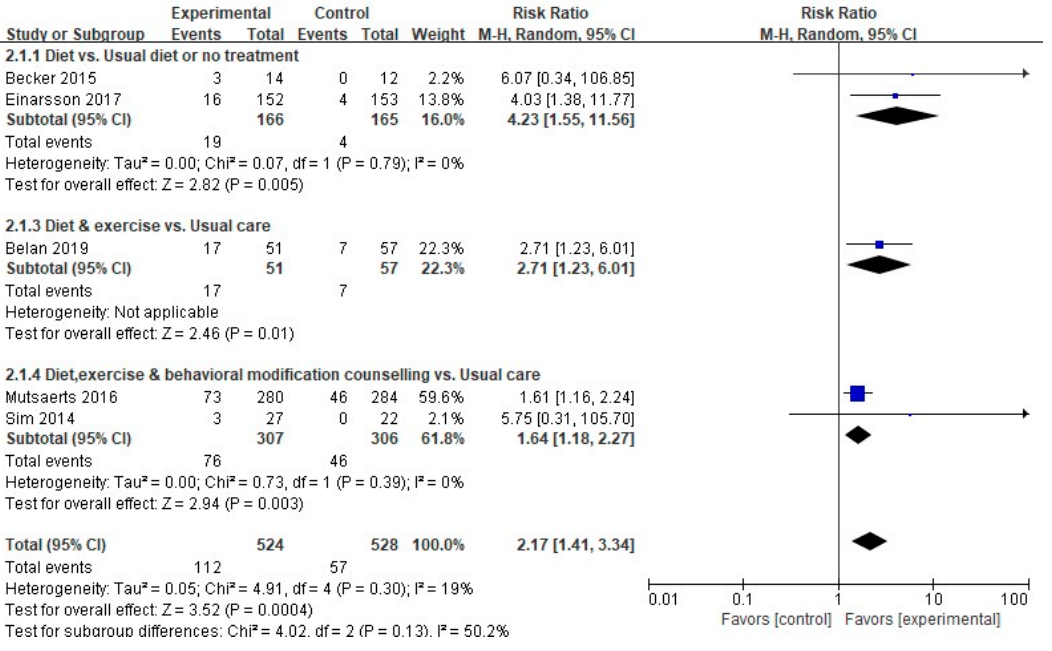
Figure 5. Forest plot of nonpharmacological interventions on the natural conception rate. M-H, the Mantel-Haenszel method; Random, random effects model; CI, confidence interval.